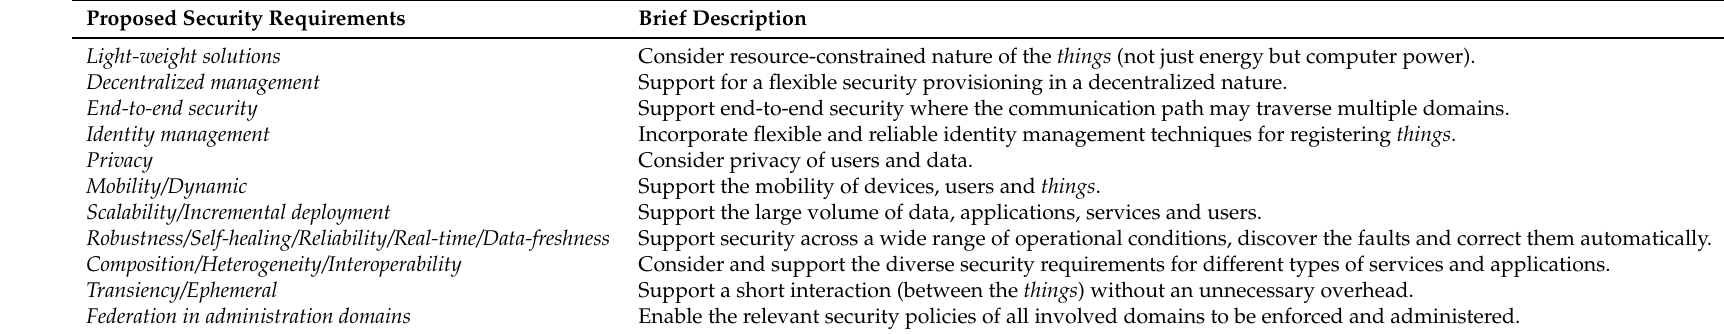
Table 5. The list and a brief outline of our approach to the IoT security